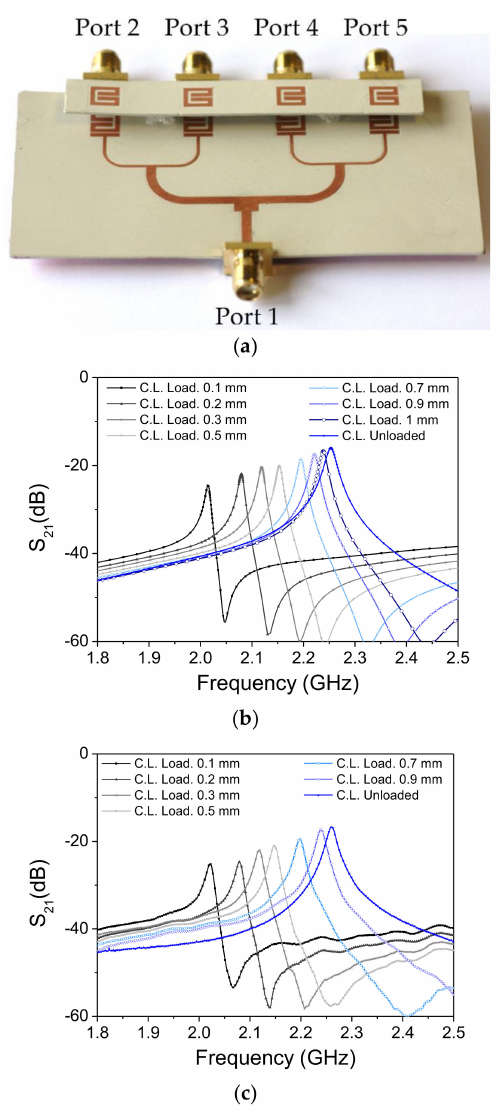
Figure 5. Frequency responses of the channel line without tag on top of it and with SRR tags (perfectly aligned) at different distances. The considered configuration is that of Figure 2c; ( a ) photograph of the prototype with tag on top and face up; ( b ) electromagnetic simulation; ( c )